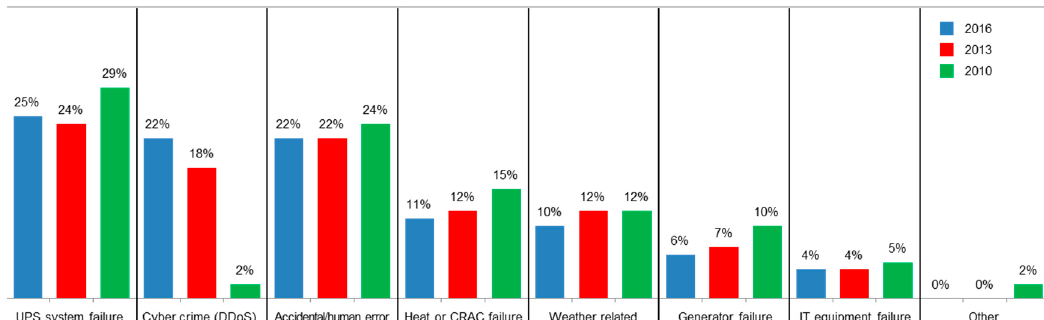
Figure 2. Root causes of unplanned outages [18].